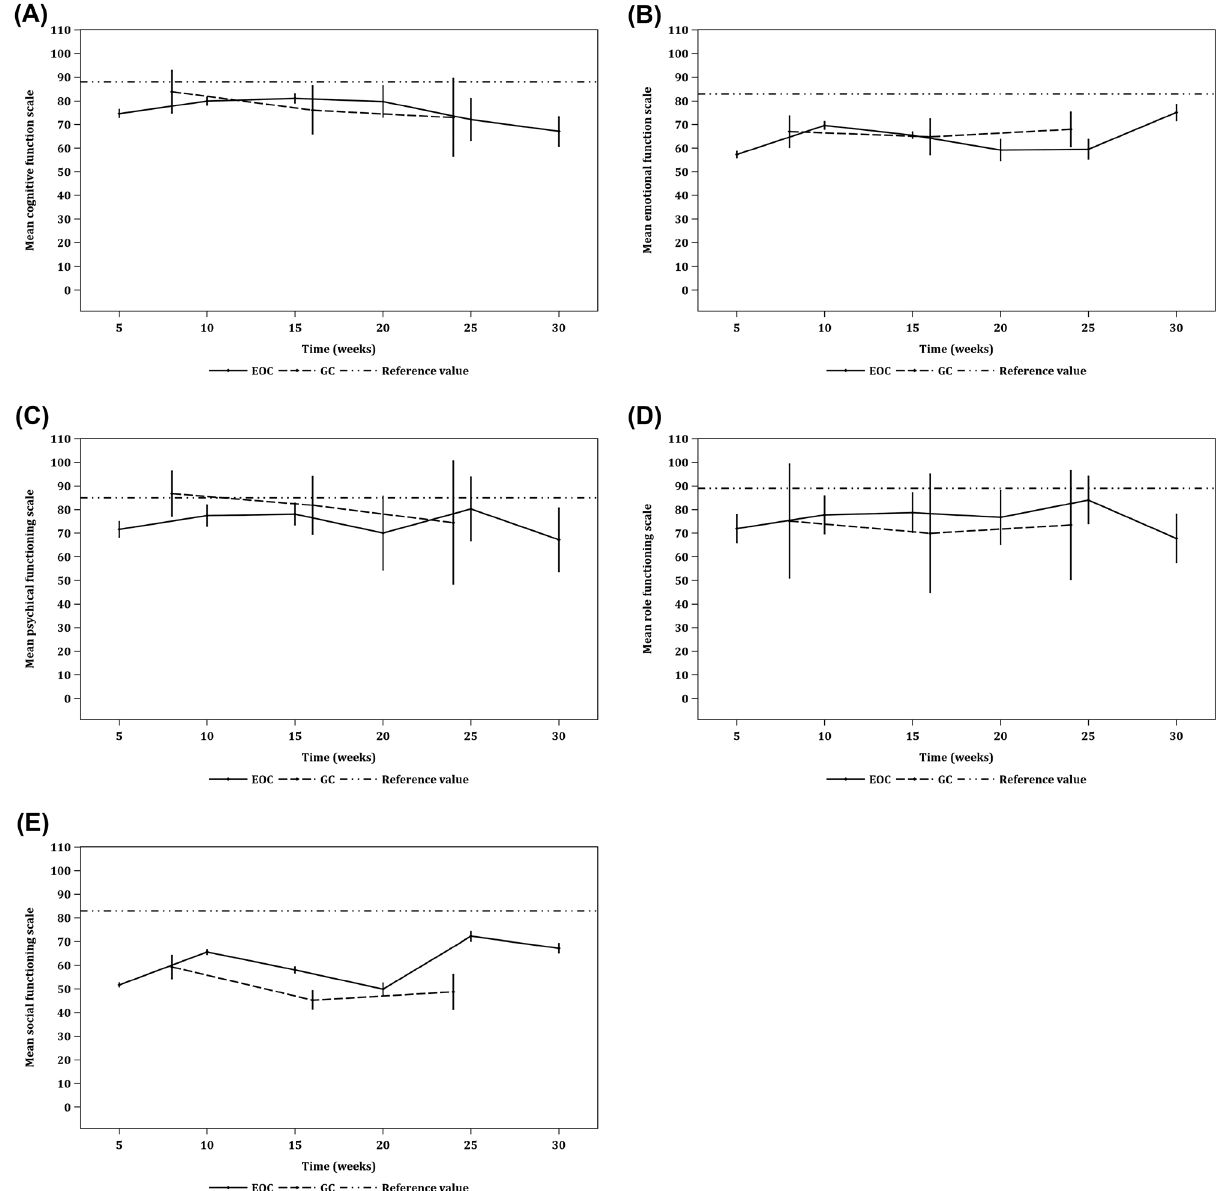
Figure 3: Line graphs depicting the five functioning scales of QoL as measured by EORTC QLQ-C30 across time. Line graphs of (A) cognitive functioning, (B) emotional functioning, (C) physical functioning, (D) role functioning, and (E) social functioning. Each three-point trendline depicts its respective functioning scores before the fi rst, second, and third cycles of PIPAC (c) in patients with PM from gastric cancer (GC); c1=31, c2=22, c3=5. Each six-point trendline depicts its respective functioning scores before the fi rst, second, third, fourth, fi fth,andsixthcyclesofPIPACinpatientswithPMfromepithelialovariancancer(EOC);c1=104,c2=70,c3=50,c4=9,c5=6,c6=4.Error bars represent 95% CIs. In each respective functioning scale of the fi ve, no signi fi cant difference was found comparing means within GC and EOC. Asa reference,eachdashed line represents a snapshotof itsrespectivefunctioningscorein 6 – 18monthsafter CRS/HIPECin a cohortof patients (n=27) with PM from a mixed histological